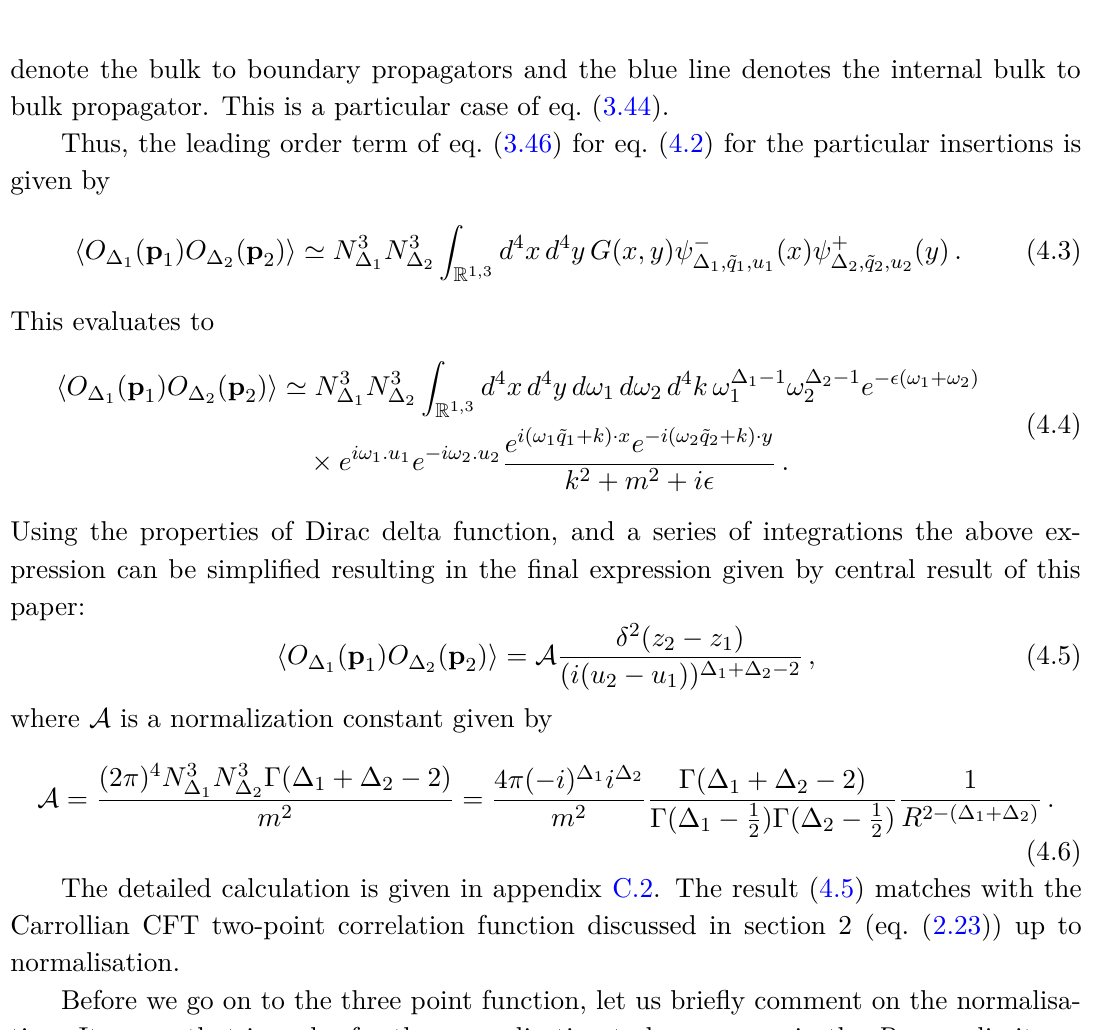
Figure 2. Two point Witten diagram. Red lines denote bulk to boundary propagators; blue line denotes bulk to bulk